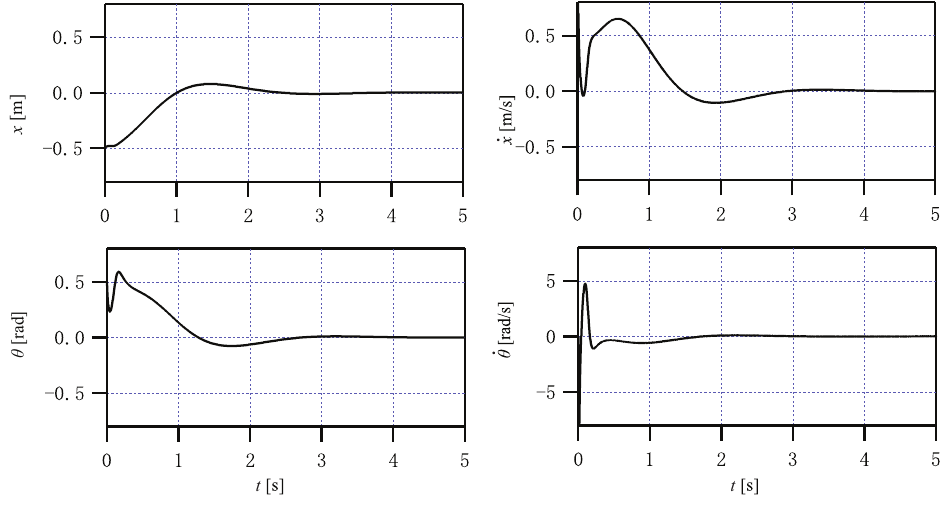
Figure 4. Time responses of the TORA system by the robust controller (29) with